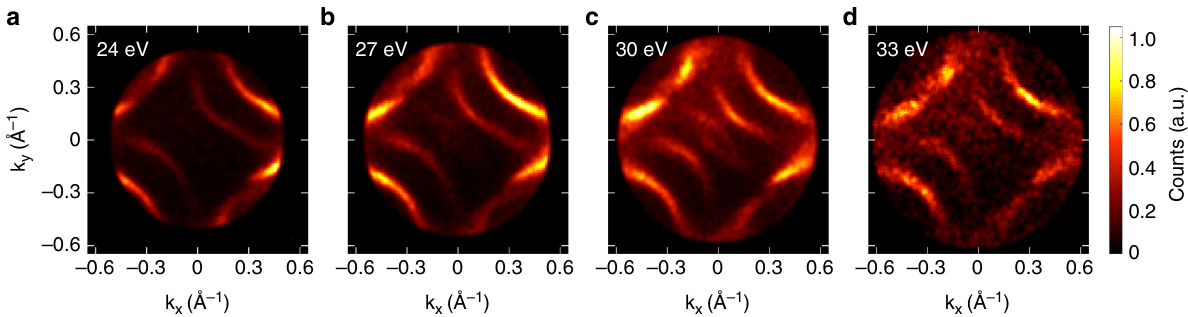
Fig. 5 Bi-2212 high-Tc superconductor. Fermi surface contours of Bi-2212 measured using different photon energies at 30 K. Fermi energy contours were acquired by integrating over a 50-meV energy window with a 24, b 27, c 30, and d 33 eV photon energies. The 33-eV measurement was acquired in a relatively shorter time as compared to those of lower